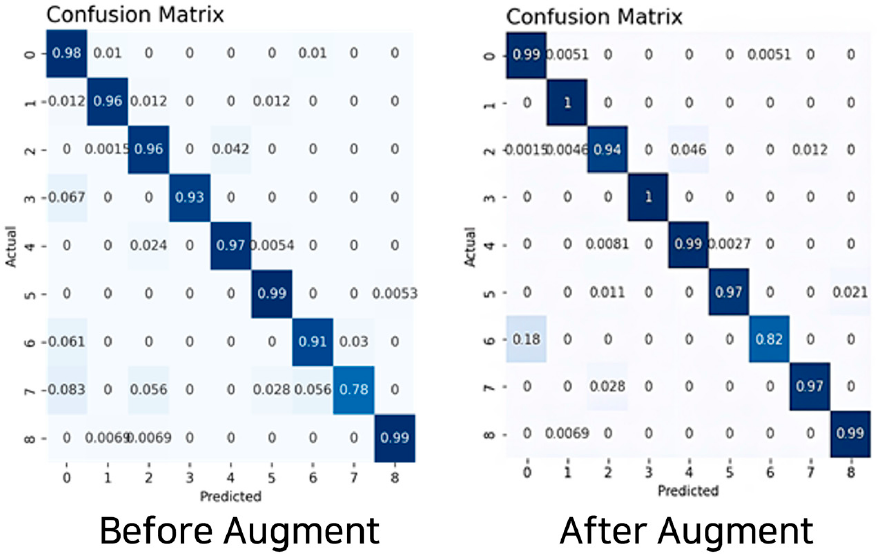
Figure 12. Behavior prediction confusion matrix using the nine-axis sensor data.